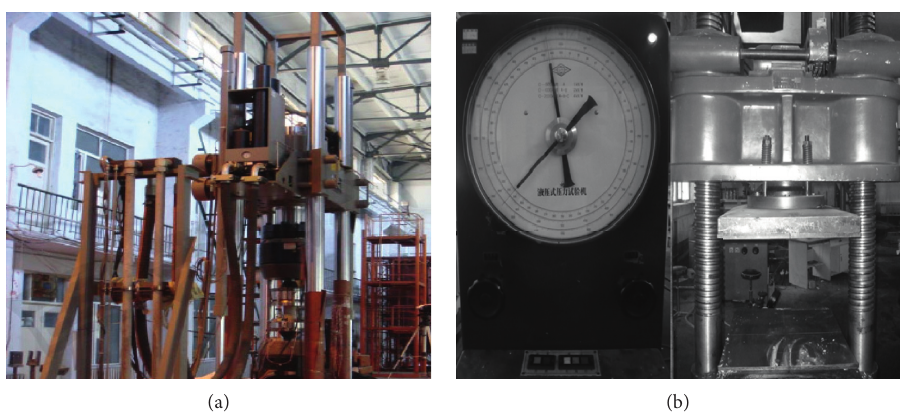
Figure 2: Test equipment: (a) MTS electrohydraulic servo testing machine; (b) hydraulic testing machine.